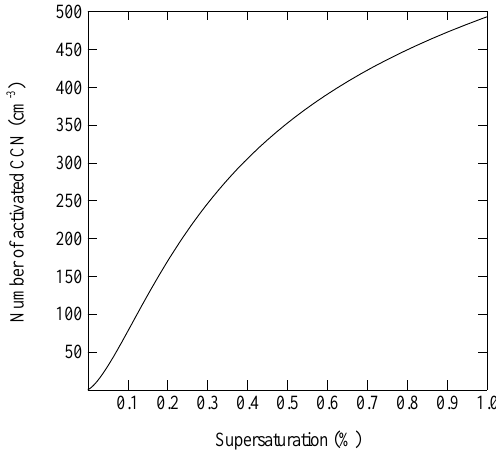
Fig. 1. Number of activated CCN in function of the supersaturation obtained from Cohard et al. (2000) for the continental case, with concentration of activated CCN at a very high (infinite) supersatu- ration of 1236cm − 3